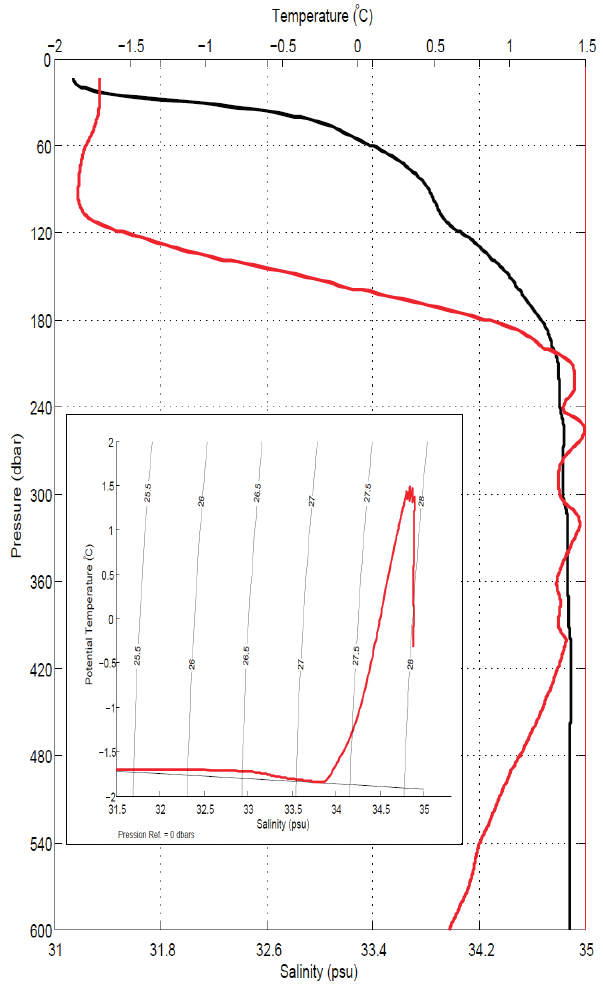
Figure 10. Temperature (red) and salinity (black, in practical salin- ity units) profile and temperature–salinity diagram (inner plot) of a sounding profile from 29 October 2006, close to the Laptev Sea. The isolines in the temperature–salinity diagram show the water den- sity subtracted by 1000kgm − 3 . Reproduced with permission from Bourgain and Gascard (2011).